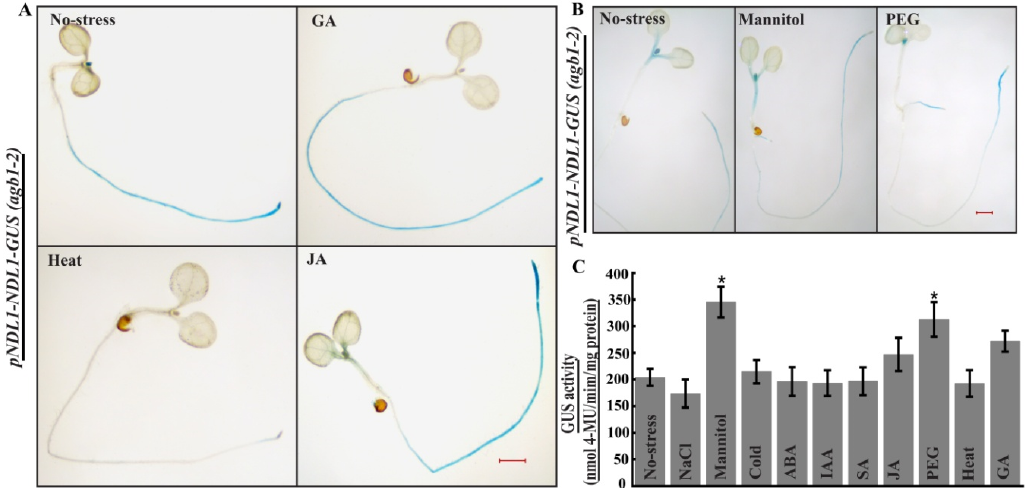
Figure 8. In vivo histochemical GUS staining of 6-day old transgenic Arabidopsis seedlings ( pNDL1-NDL1-GUS ) in agb1-2 mutant background: Histochemical GUS staining was done in transgenic Arabidopsis seedlings that were six days old treatment was given for 24 h. ( A ) Changes in GUS intensity levels were detected with GA, heat and JA. ( B ). Increased GUS staining detected for Mannitol and PEG at the cell division and elongation part of the primary root. ( C ) Abiotic stress treatments followed by fluorometric MUG assay was done for quantitative estimation of stress response. Significantly higher GUS activity was obtained for Mannitol and PEG treatment compared to No-stress control indicative of NDL1 involvement during osmotic and drought responses (Students t -test = * p value < 0.05, Error bars represent SD). Result shown is representative of three independent biological replicates ( n ≥ 10 in each experiment). Scale Bar = 0.2 µ